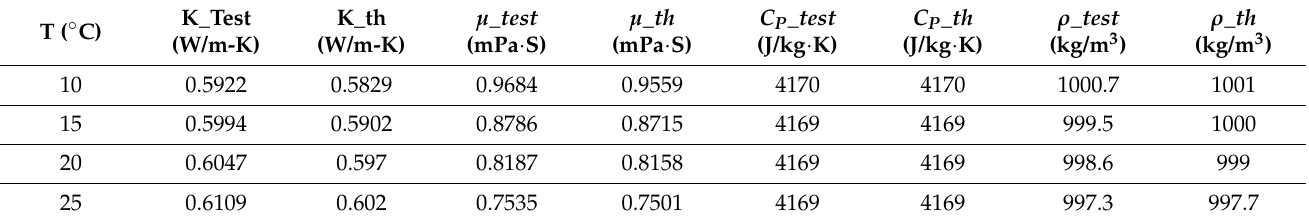
Table 6. Comparison of experimental and theoretical data for thermo-physical properties of Al 2 O 3